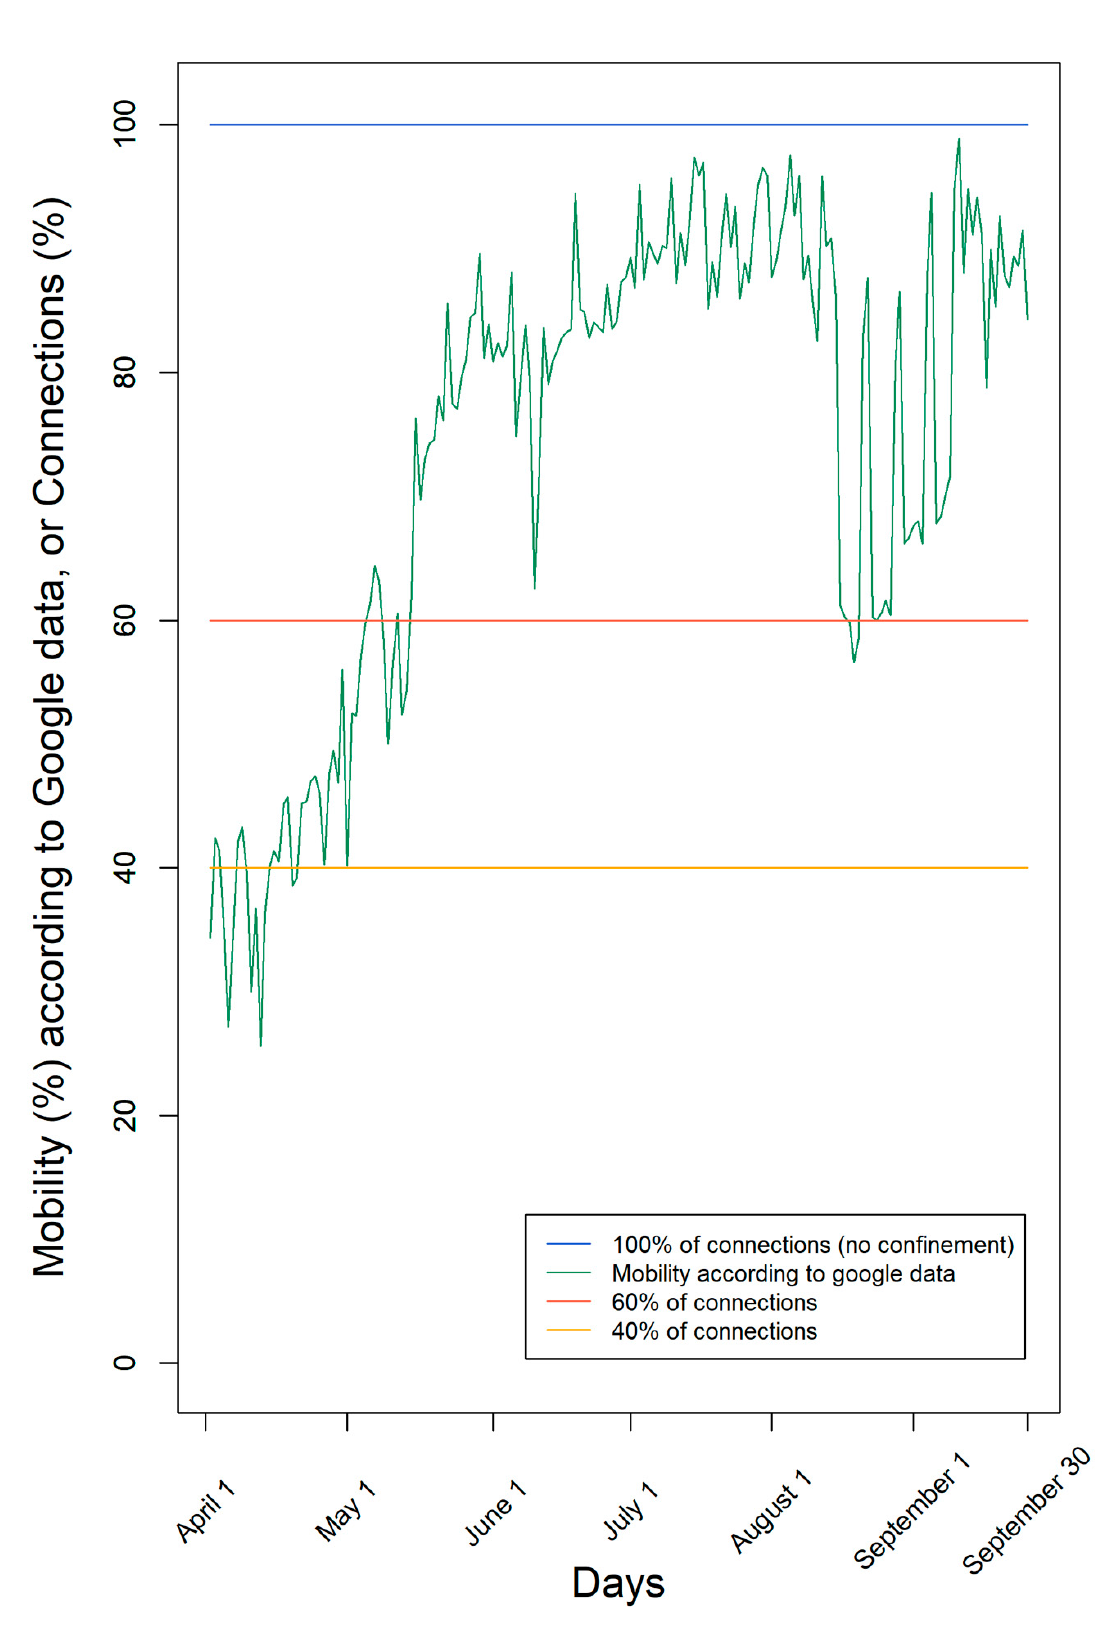
Figure 1. Levels of confinement used in the simulations. We used either a fixed number of connections (100%, 60%, or 40%) or mobility according to Google data from the region of Lisbon and Tagus Valley in Portugal in the period 1 April–30 September.